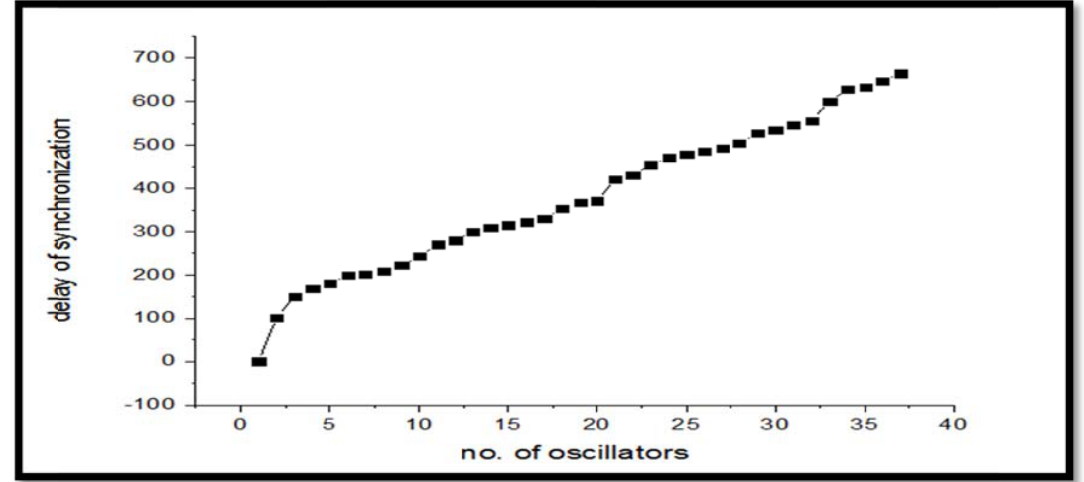
Delay of syn nchronizatio on for 37 osc time requir